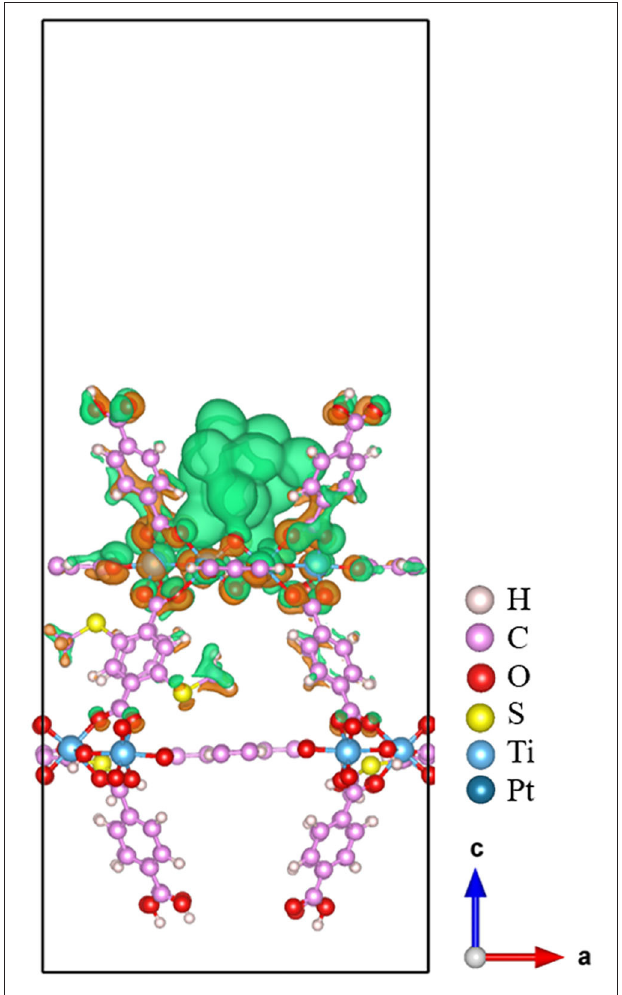
FIGURE 4 | The charge density difference for Pt 13 /20%-MIL-125-(SCH 3 ) 2 . The electron accumulation region is colored using the orange, while green for the electron depletion